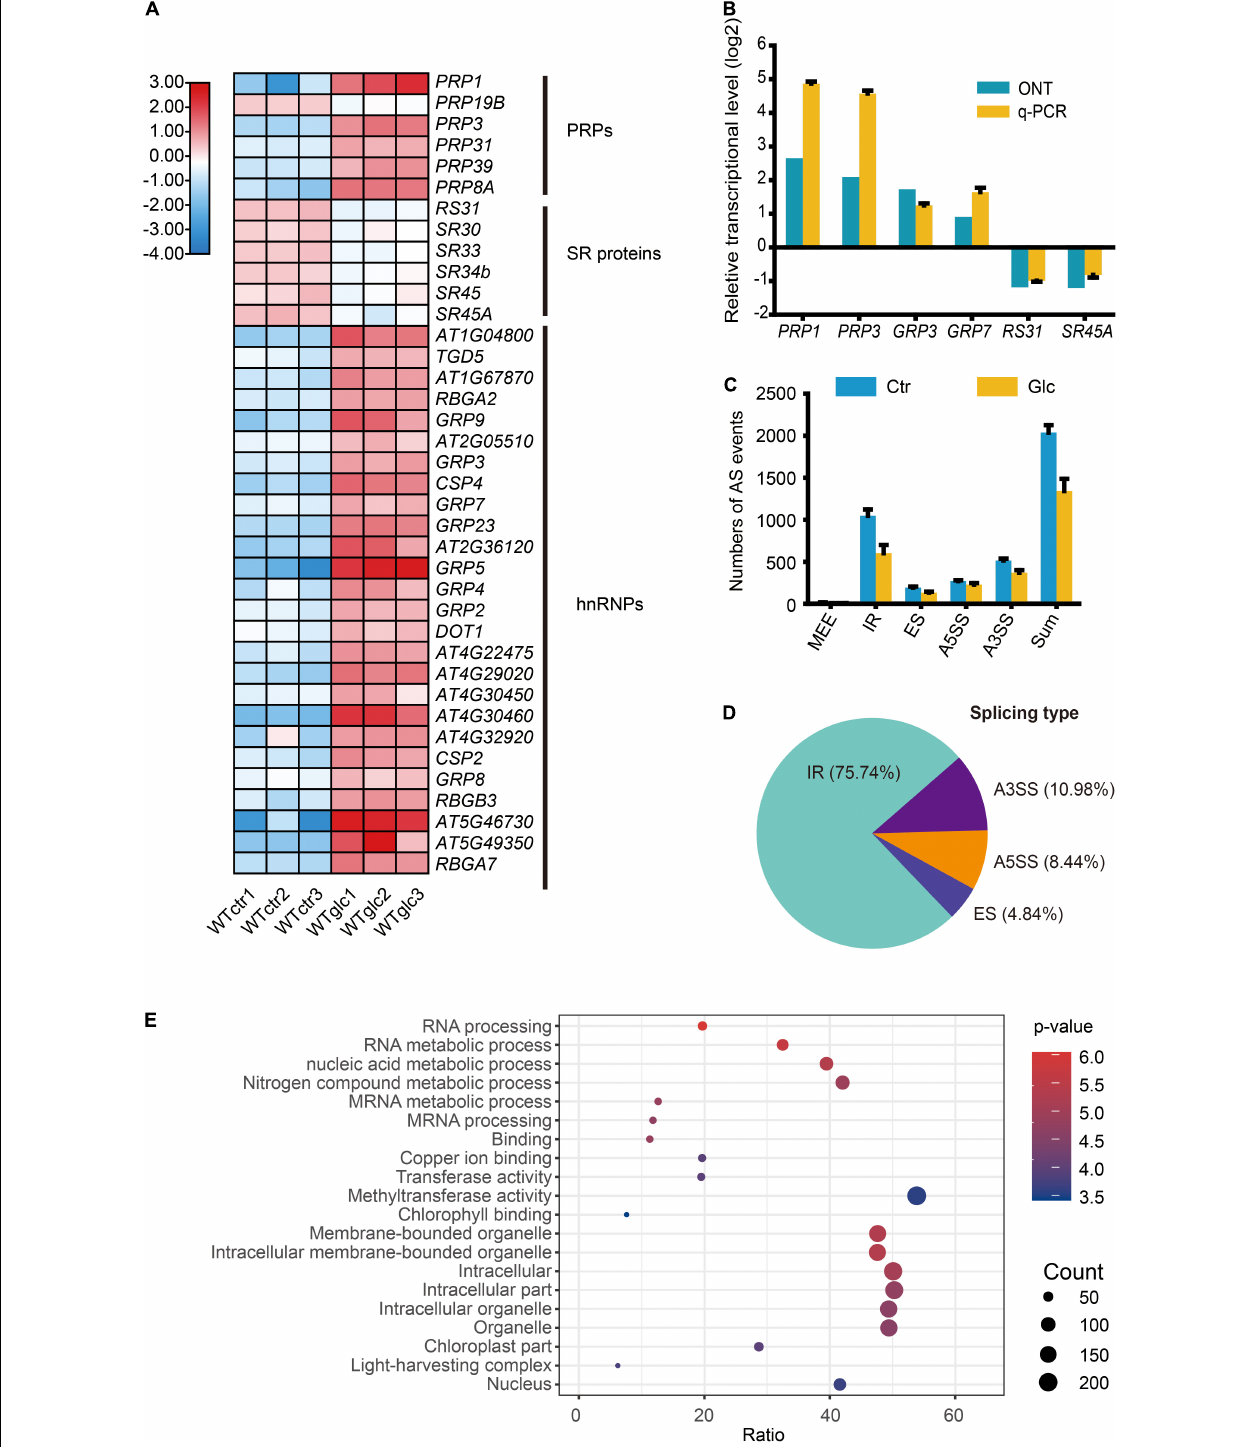
FIGURE 2 | Glucose stress regulates alternative splicing (AS) in Arabidopsis seedling. (A) Heatmap for the differentially expressed splicing factors regulated by 3% glucose treatment. (B) Nanopore sequencing and q-PCR results for representative splicing factors induced by 3% glucose treatment. (C) The numbers of AS events in different types in WT_Ctr and WT_Glc samples. (D) The type distribution of the differential alternative splicing (DAS) events between WT_Ctr and WT_Glc. IR, intron retention; A5SS, alternative 5 (cid:48) splicing site; A3SS, alternative 3 (cid:48) splicing site; ES, exon skipping. (E) The air bubble graph showing GO enrichments in differentially alternative spliced genes (DSGs) between WT_Ctr and WT_Glc. Gene numbers (circle size) and enrichment q -value (circle color) are shown.